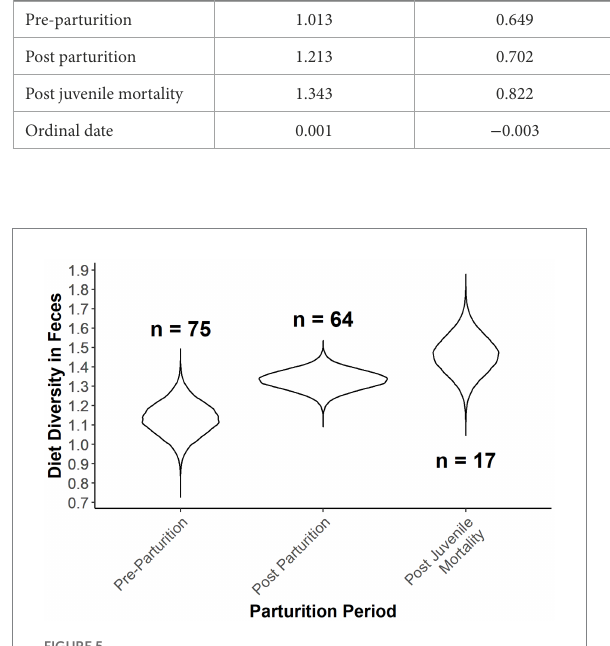
FIGURE 5 Expected Shannon diversity index as a function of Ordinal date and provisioning status of female desert bighorn sheep at Lone Mountain, Nevada (2016–2018). Violin plots represent the posterior distributions for the predicted mean values derived from an ANCOVA model of Shannon diversity index modeled as a function of provisioning status at Ordinal date 115, which was fitted in a Bayesian framework ( n =